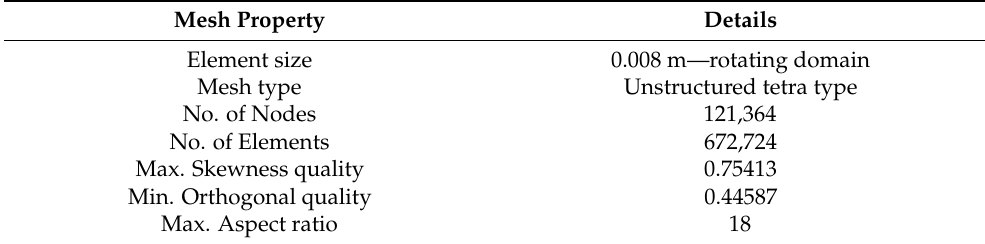
Table 5. Mesh properties and